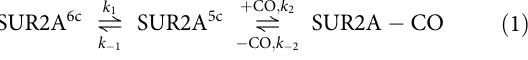
Fig. 2 CO binds to heme-binding motif on SUR2A. a Spectrophotometric titration of the ferrous heme-SUR2A 615 – 933 complex with CO. Inset top: quadratic (Morrison) fi tting to the binding curve to give K d = 0.6 ± 0.3 μ M; inset bottom: an expansion of the visible region. b Stopped- fl ow spectra (pH 7.5, 22.0 °C) observed on binding of CO (300 μ M) to the ferrous heme-SUR2A 615 – 933 complex (2 μ M). Inset top: kinetics transient observed on binding of CO (300 μ M) to the ferrous heme-SUR2A complex, monitored as an increase at 420 nm; data were fi tted to a three-exponential process. Inset bottom: Observed rate constants for the fi rst phase, k obs (s − 1 ), plotted as a function of CO concentration; there is an asymptotic phase with a rate constant ( k 1 ) that corresponds to the off-rate of the distal residue. A fi t of k obs to the hyperbolic equation [1] (see Results section) gives k 1 = 25 ± 5 s − 1 and an effective second order rate constant at low [CO] k CO = k 1 k 2 / k − 1 = 0.27 ± 0.10 μ M − 1 s − 1 . Using k − 2 = 0.05 ± 0.01 s − 1 (as calculated from ligand substitution, Fig. 2c), a value for K d = k − 2 / k CO = 0.19 ± 0.10 μΜ is predicted which is in good agreement with the K d measured independently ( K d = 0.6 ± 0.3 μ M, Fig. 2a). c Kinetics and spectral changes associated with dissociation of CO from the ferrous heme-SUR2A 615 – 933 complex (3 μ M) in the presence of NO. NO